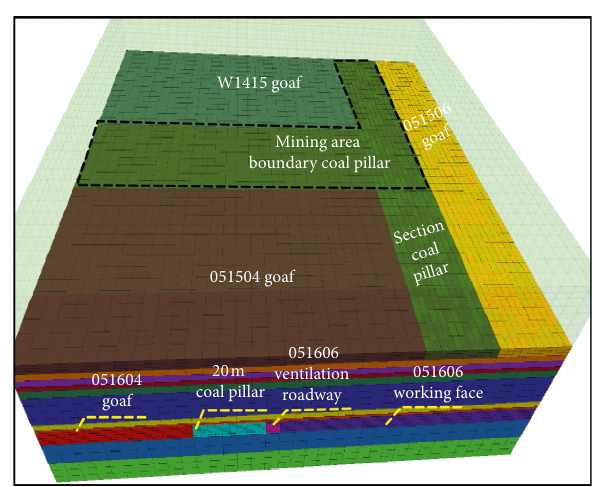
Figure 6: Initial numerical